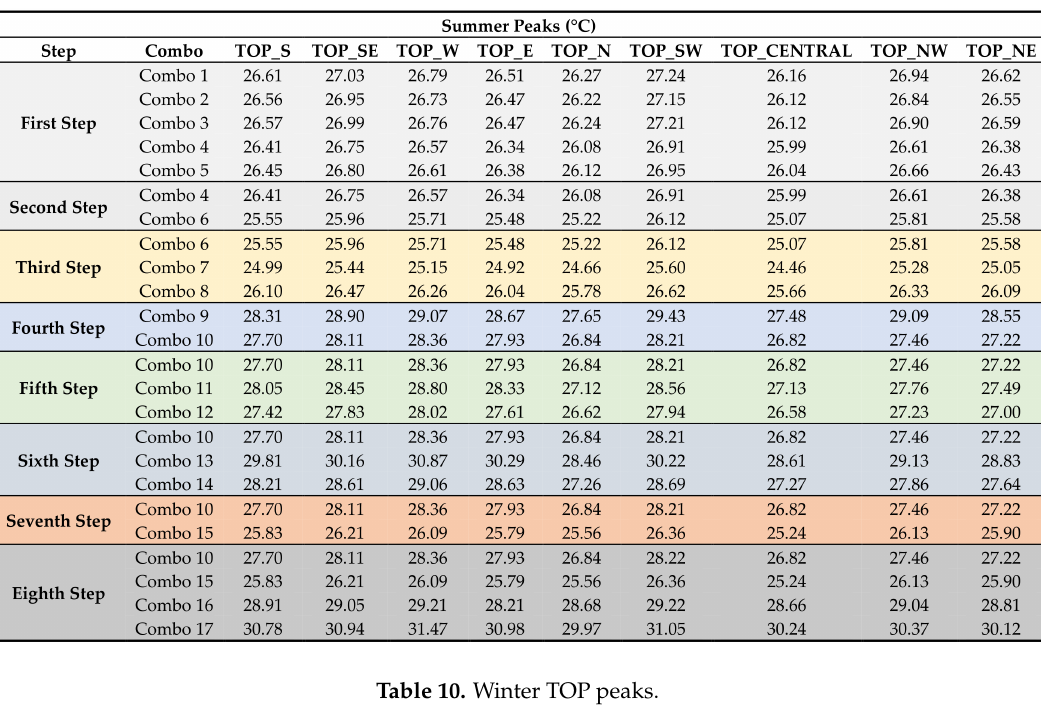
Table 10. Winter TOP